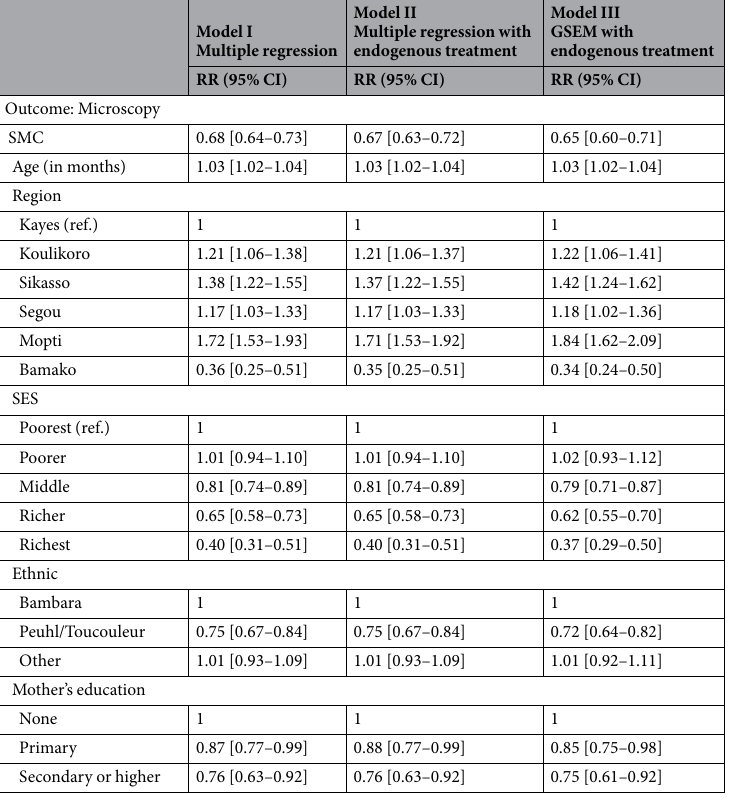
Table 3. Models of the effects of SMC on microscopy-confirmed malaria. Wald test of no correlation between outcome and treatment equations (Model II): χ 2 = 10.25 (0.001). RR risk ratio; CI confidence interval; SMC seasonal malaria chemoprevention; SES socioeconomic status; GSEM generalized structural equation